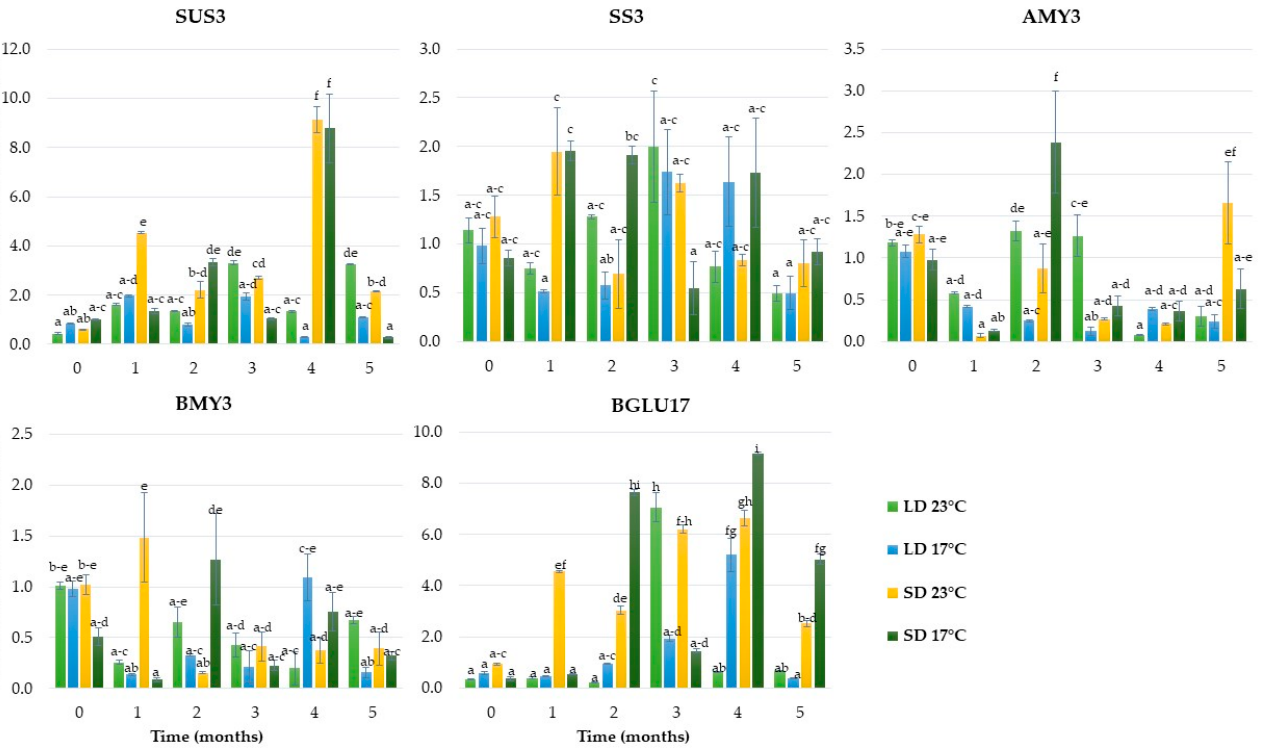
Figure 5. The relative expression of the genes involved in carbohydrate metabolism in rhubarb buds during five months of ex vitro growth under different temperatures (17 °C and 23 °C) and photoperiods (16 h and 10 h). According to Duncan’s test ( p = 0.05), means marked with the same letter do not differ significantly ( p = 0.05). Error bars represent standard deviation.